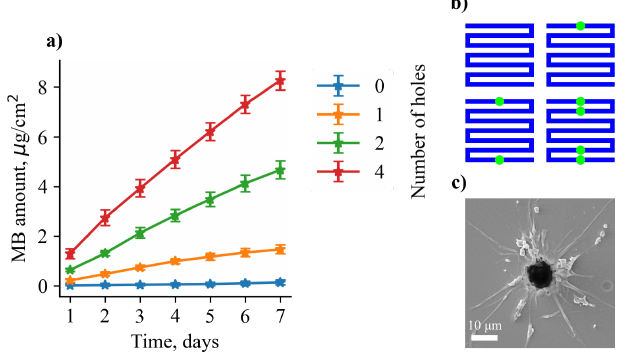
Figure 4. ( a ) One week MB elution data depending on the number of laser made holes. ( b ) Locations in which holes are made for different groups of samples—0, 1 , 2, 4 holes, respectively. Locations are indicated as green circles. ( c ) SEM image of the laser-induced hole. Mean hole diameter is 10 µm.